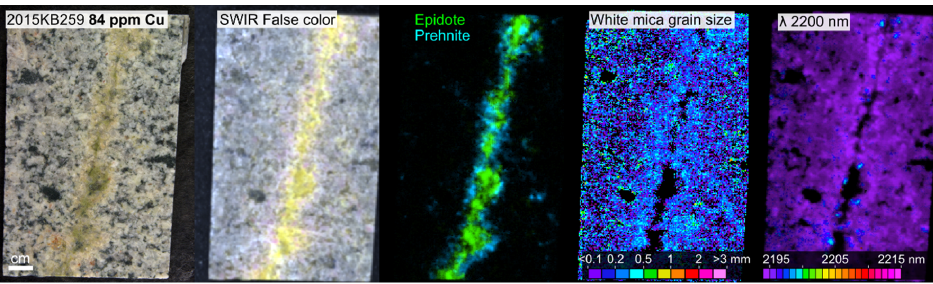
Figure A3. Sample 2247917, pumpellyite-rich zone.